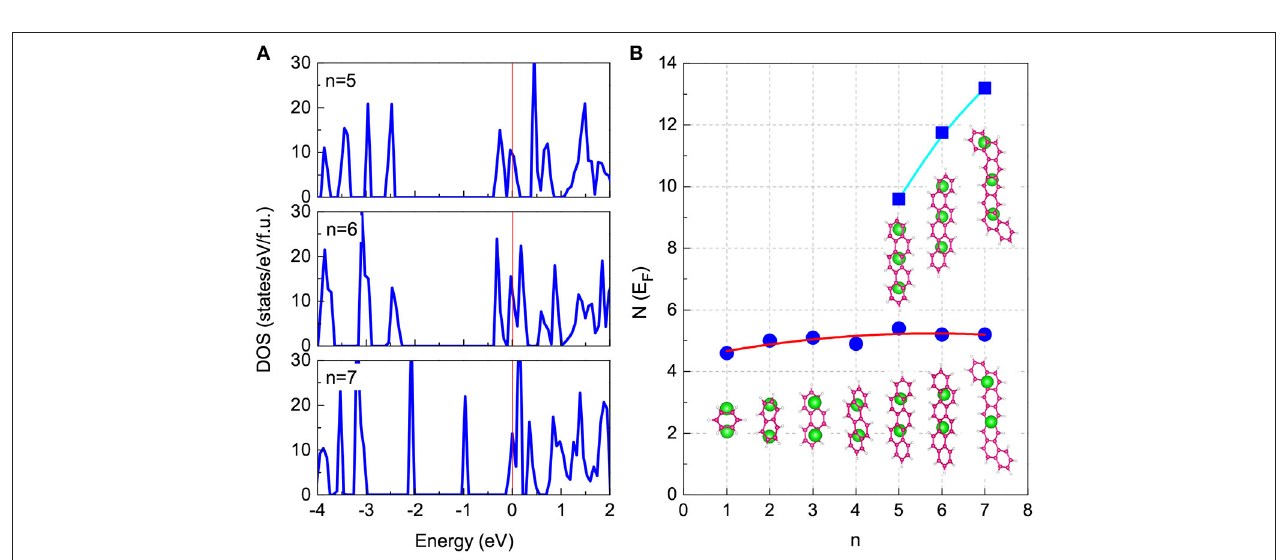
FIGURE 6 | Total DOS for K 3 -doped cases with the long-benzene-ring chain. (A) The results of DOS for K 3 -doped cases of K 3 C 22 H 14 , K 3 C 26 H 16 , and K 3 C 30 H 18 are presented. Zero energy denotes the Fermi level. (B) The N(E F ) of K 3 -doped cases is compared with that of K 2 -doped cases. The corresponding structures are also